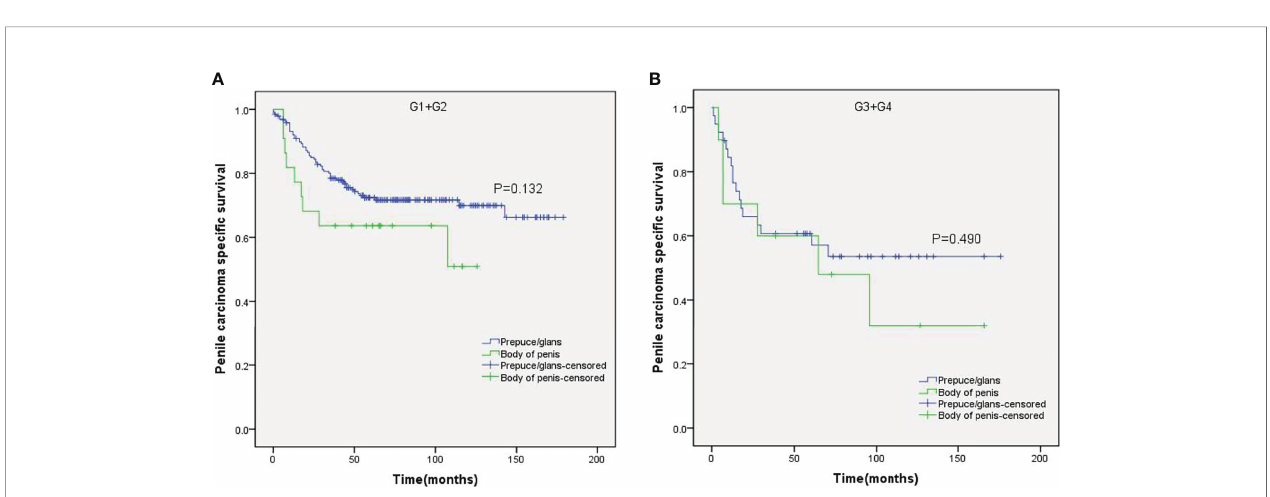
FIGURE 9 | Kaplan – Meier analyses of penile carcinoma-speci fi c survival in G1+G2 group (A) and G3+G4 group (B) in patients strati fi ed by tumor location.